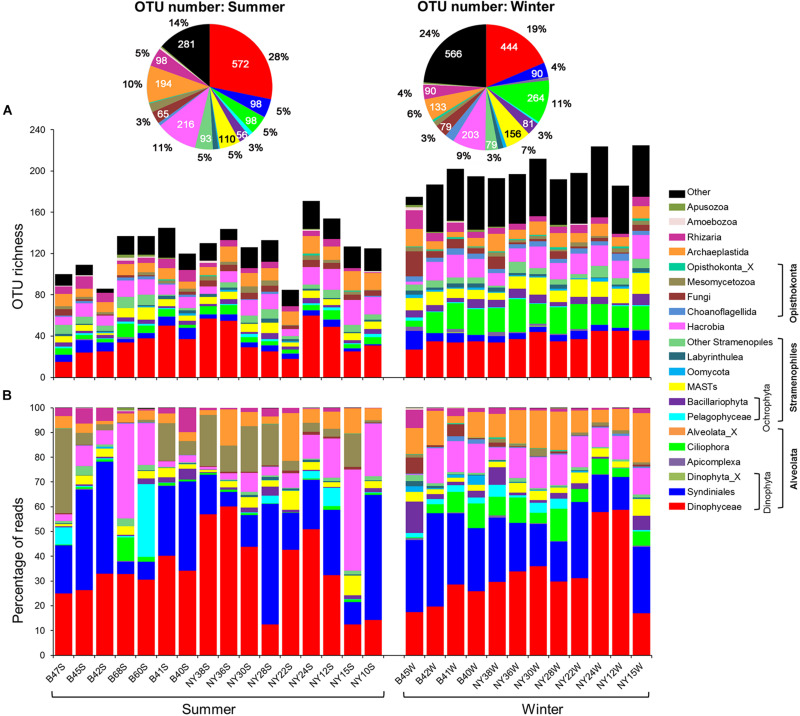
Variations in OTU richness and community composition of pico-/nanoeukaryotes. (A) The column chart shows the variation in OTU numbers of major taxa among samples; the pie charts summarize the OTU numbers and proportions of major taxa in summer and winter, respectively. (B) Relative proportions of pyrotags of major taxa across samples. MASTs, marine stramenopiles.